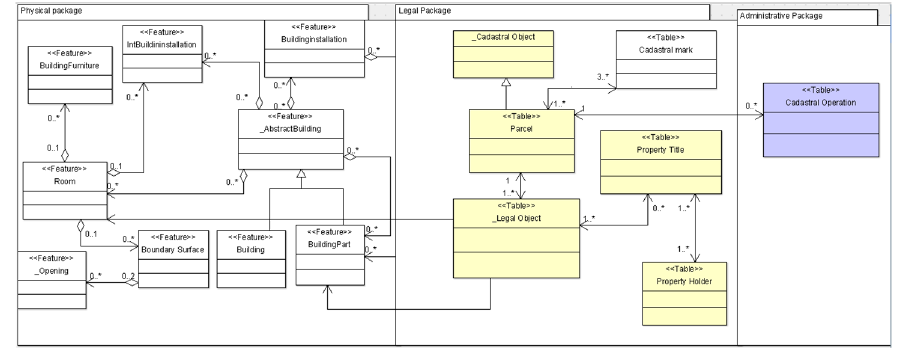
Figure 6. CityGML extension for the Cadastre Data Model.